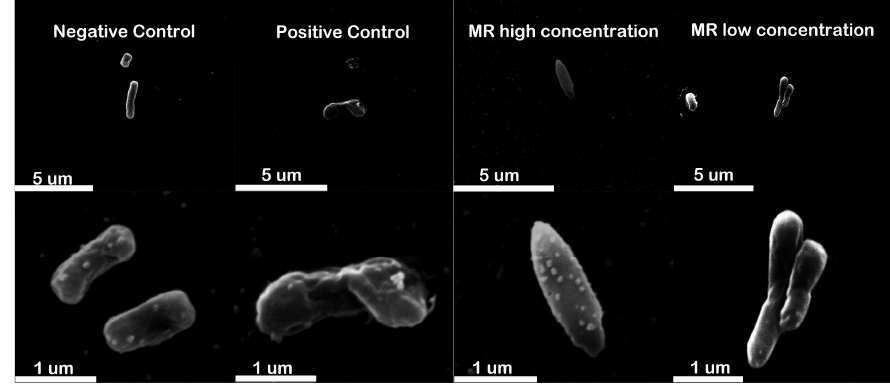
Figure 6. The cell morphology of the peptide-treated E. coli BL21 is shown. Negative control group: E. coli BL21 was treated without peptides. Positive control groups: E. coli BL21 was treated with GL at twice of the lethal concentration for up to 60 min. E. coli BL21 was treated with MR at twice of the 5.34 mM for up to 60 min, dubbed “MR high concentration”. E. coli BL21 was treated with MR at 0.05 mM for up to 60 min, dubbed “MR low concentration”. Results are typical results of three separate experiments. Approximately 2 × 10 7 cells (in 50 μ L) were transferred into a 1.5-mL Eppendorf tube and the peptide was added at the desired concentration.